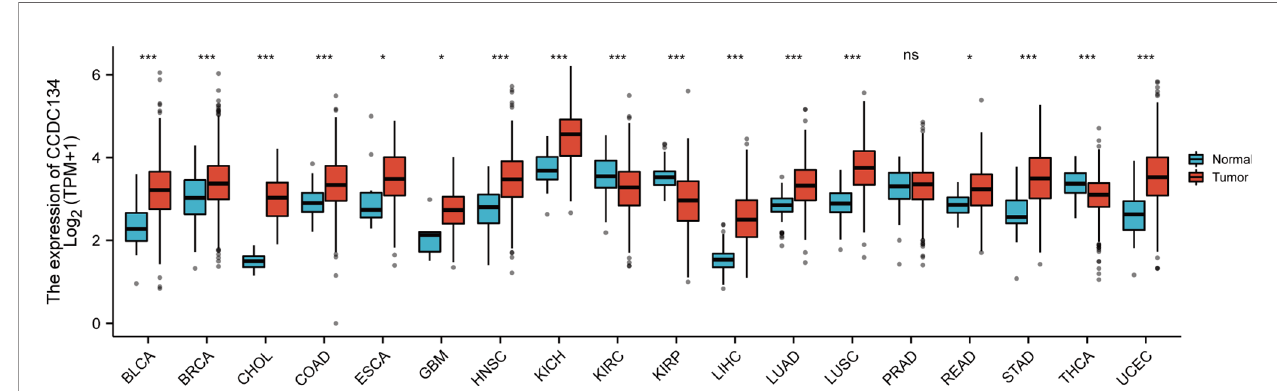
FIGURE 1 | Expression pattern of CCDC134 from the perspective of pan-cancer. CCDC134 mRNA expression was signi fi cant in 17 of the 18 cancers compared with normal tissue. (ns, p ≥ 0.05; *p< 0.05; ***p<0.001). BLCA, Bladder Urothelial Carcinoma; BRCA, Bladder Urothelial Carcinoma; CHOL, Cholangiocarcinoma, COAD, Colon adenocarcinoma; ESCA, Esophageal carcinoma, GBM, Glioblastoma multiforme; HNSC, Head and Neck squamous cell carcinoma; KICH, Kidney Chromophobe; KIRC, Kidney renal clear cell carcinoma; KIRP, Kidney renal papillary cell carcinoma; LIHC, Liver hepatocellular carcinoma; LUAD, Lung adenocarcinoma; LUSC, Lung squamous cell carcinoma; PRAD, Prostate adenocarcinoma; READ, Rectum adenocarcinoma; STAD, Stomach adenocarcinoma; THCA, Thyroid carcinoma; UCEC, Uterine Corpus Endometrial